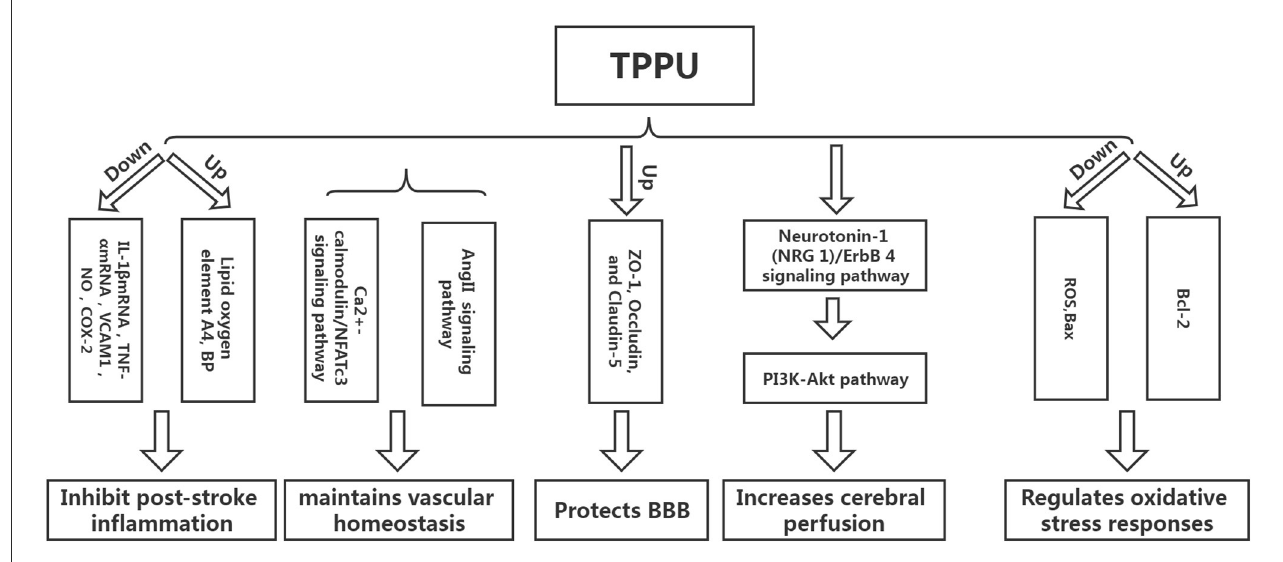
FIGURE3 The protective mechanism of TPPU on